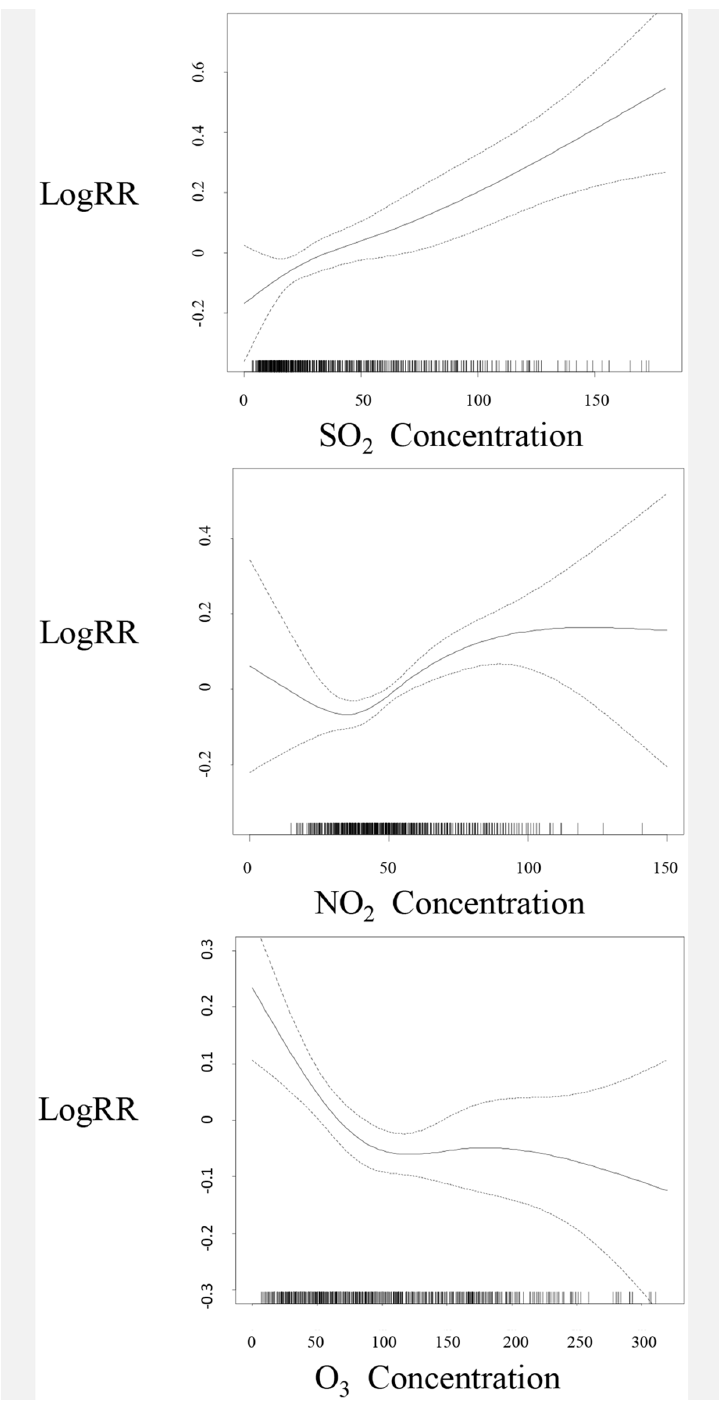
Fig 3. Smoothing plots of air pollution. X-axis is the concentration of pollutants ( μ g/m3). The estimated mean percentage of change in daily outpatient-visits for epilepsy is shown by the solid line, and the dotted lines represent twice the point-wise standard